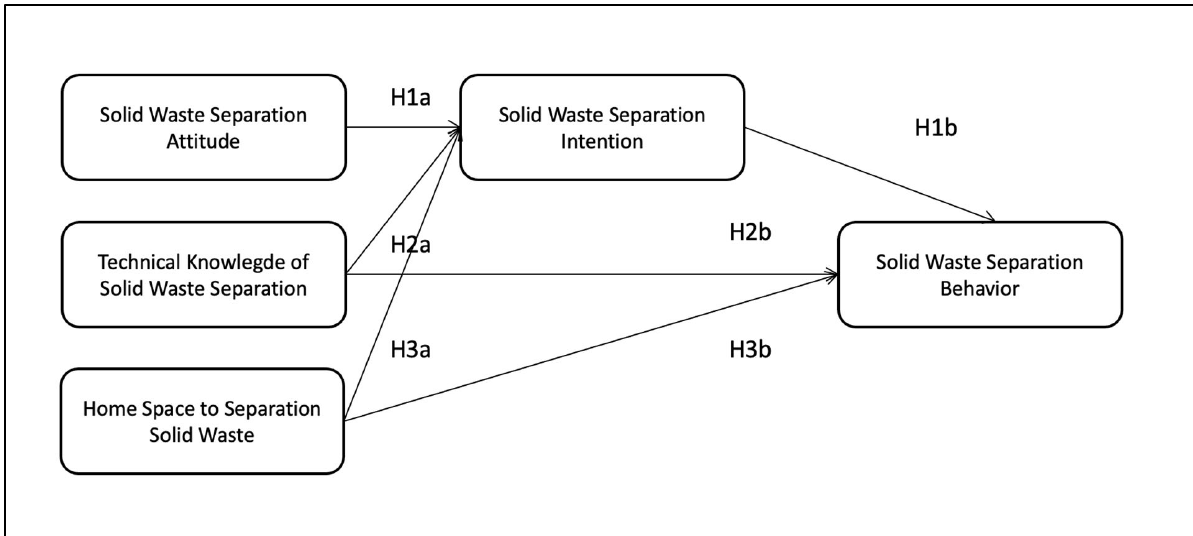
Figure 1. Proposed